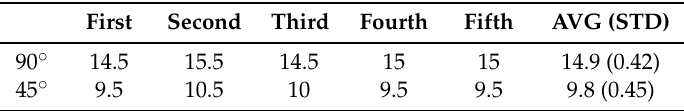
Table 7. Results of braking system test (unit: